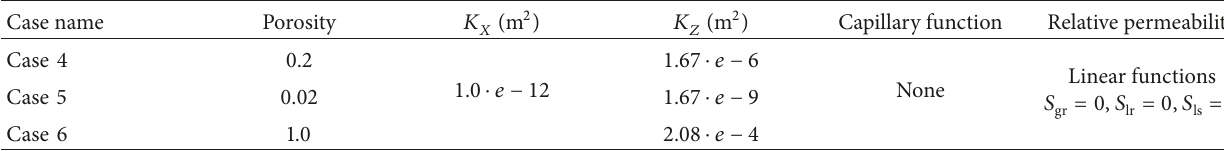
Table 3: Parameters of fracture zone in EPM